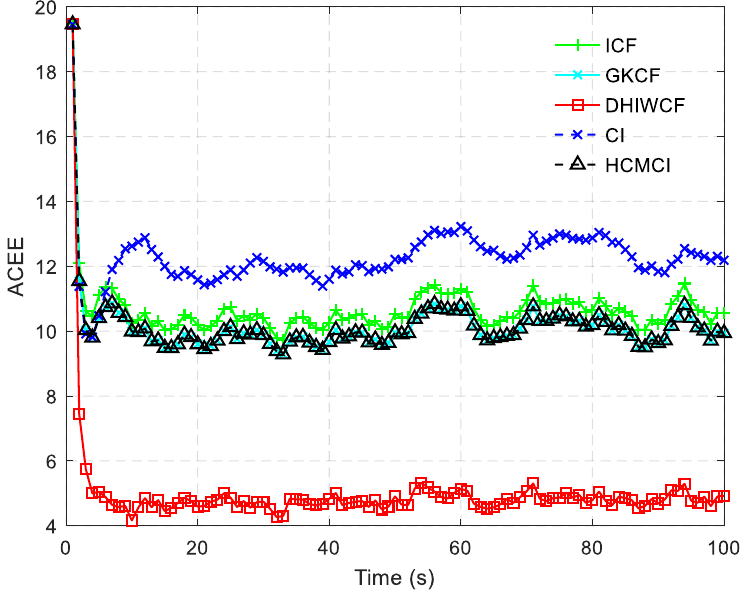
Figure 6. The averaged consensus estimate error (ACEE) for distributed algorithms.